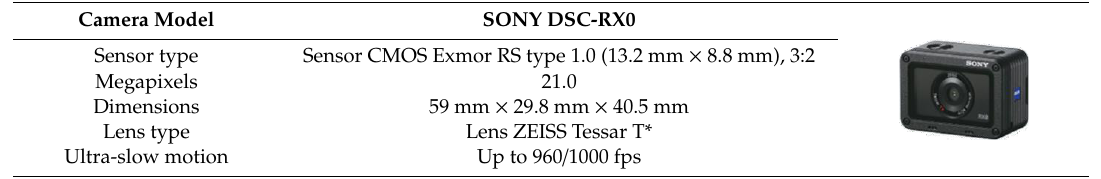
Table 2. Technical information about the High-Speed Camera used.